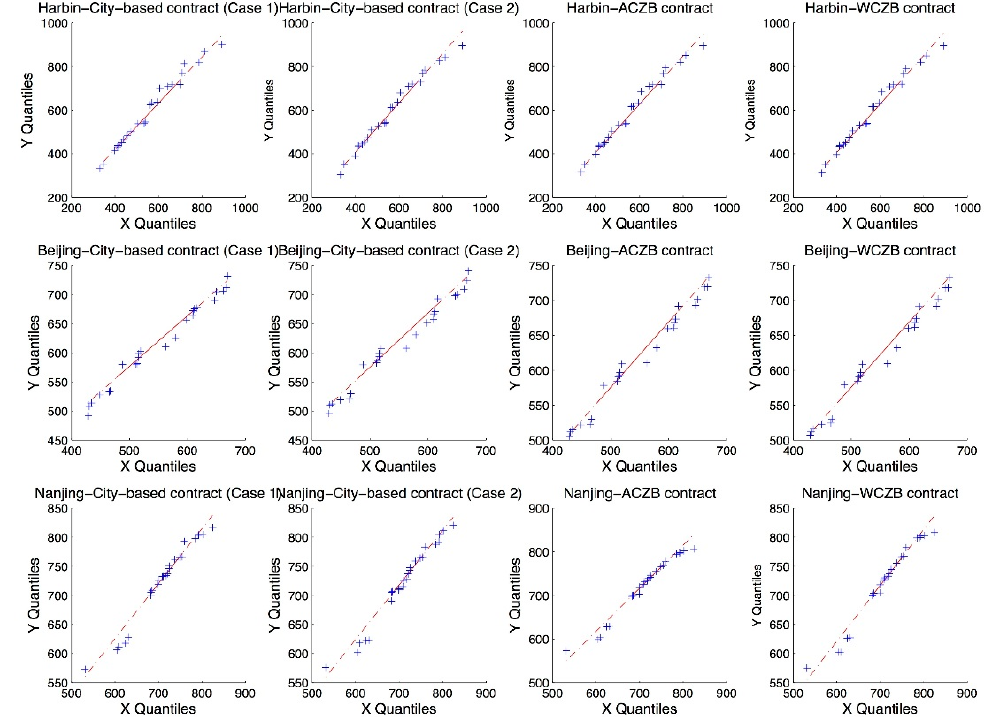
Figure 3. Q-Q plots: revenue distributions without GDD contracts, with the city-based contracts, with the ACZB contracts and with the WCZB